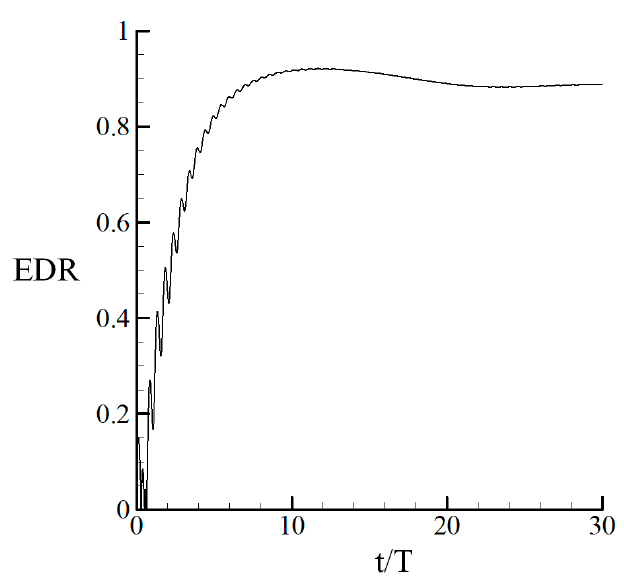
Figure 9. Time variation of the energy dissipation rate during oscillation.